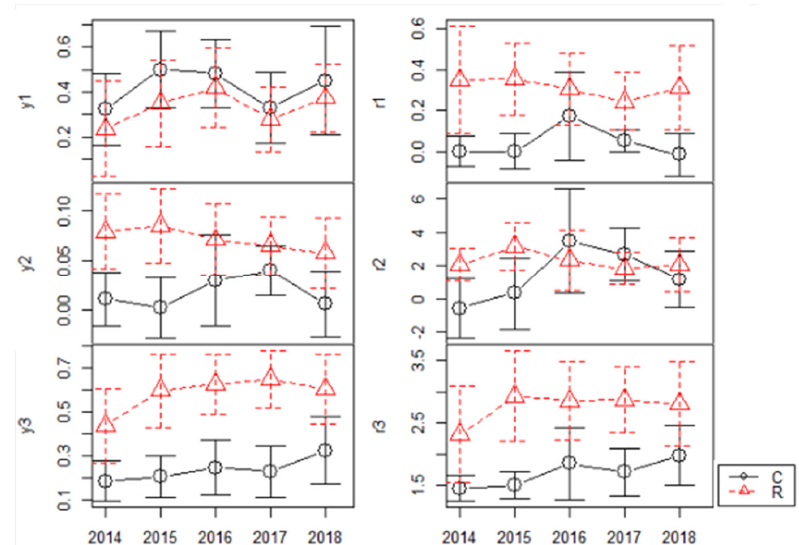
Fig. 3. Confidence intervals for the means of the standard indicators r 1 to r 3 and compositional indicators y 1 to y 3 by year and region differences at 95 %